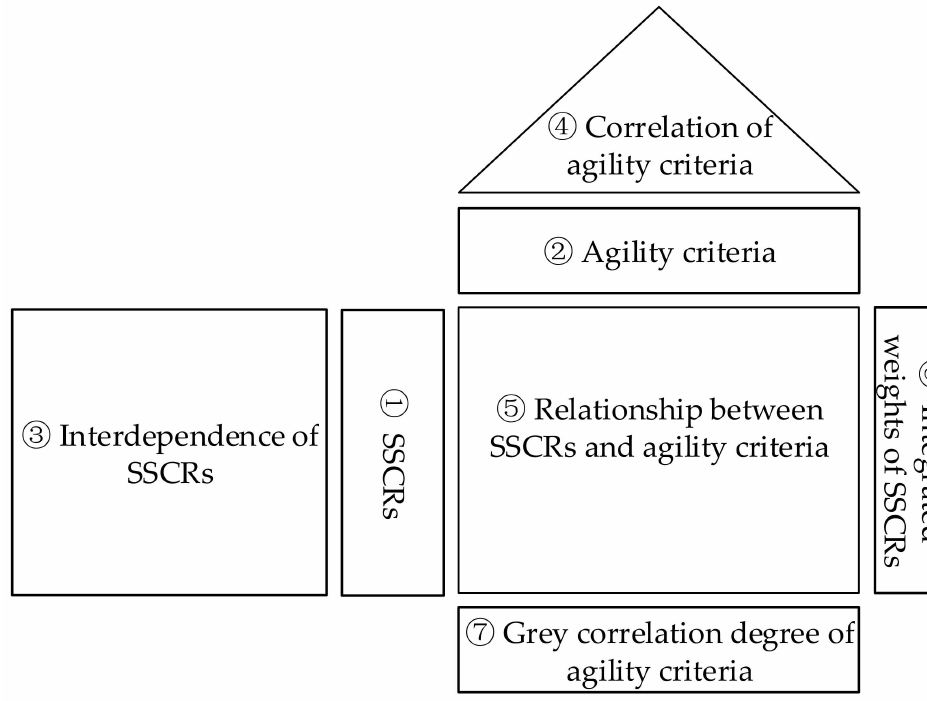
Figure 1. Structure of the